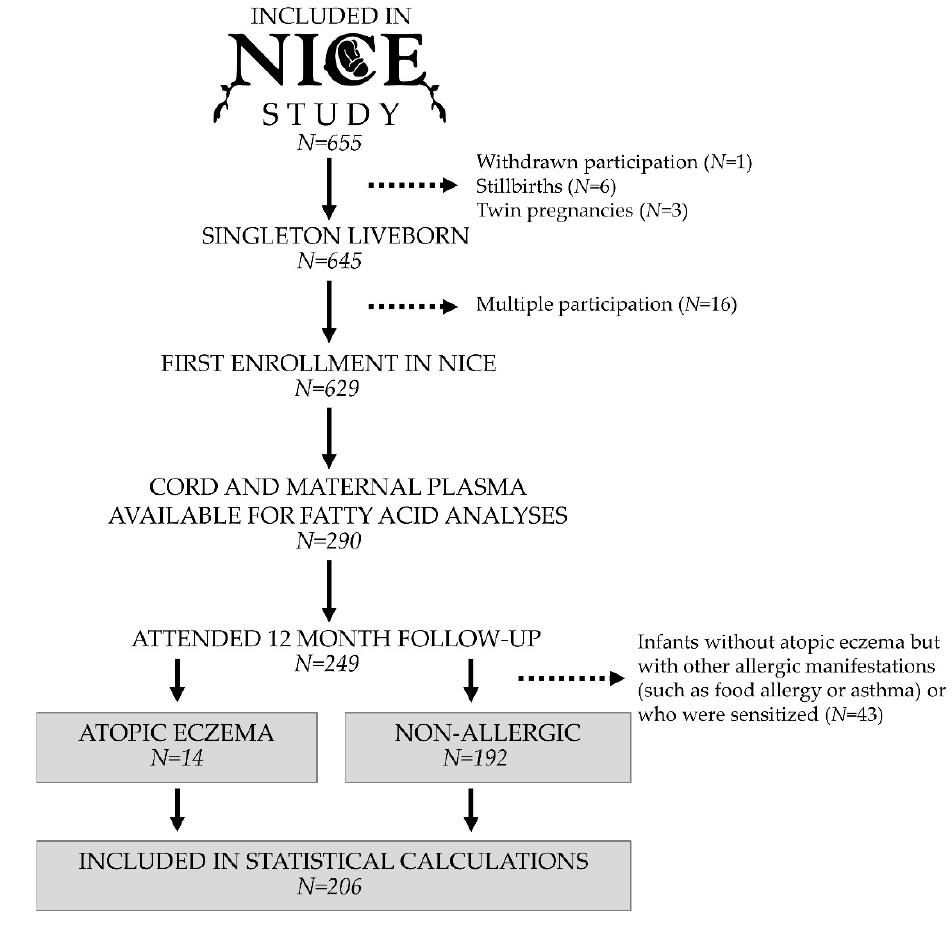
Figure 1. Flow chart of the study population.